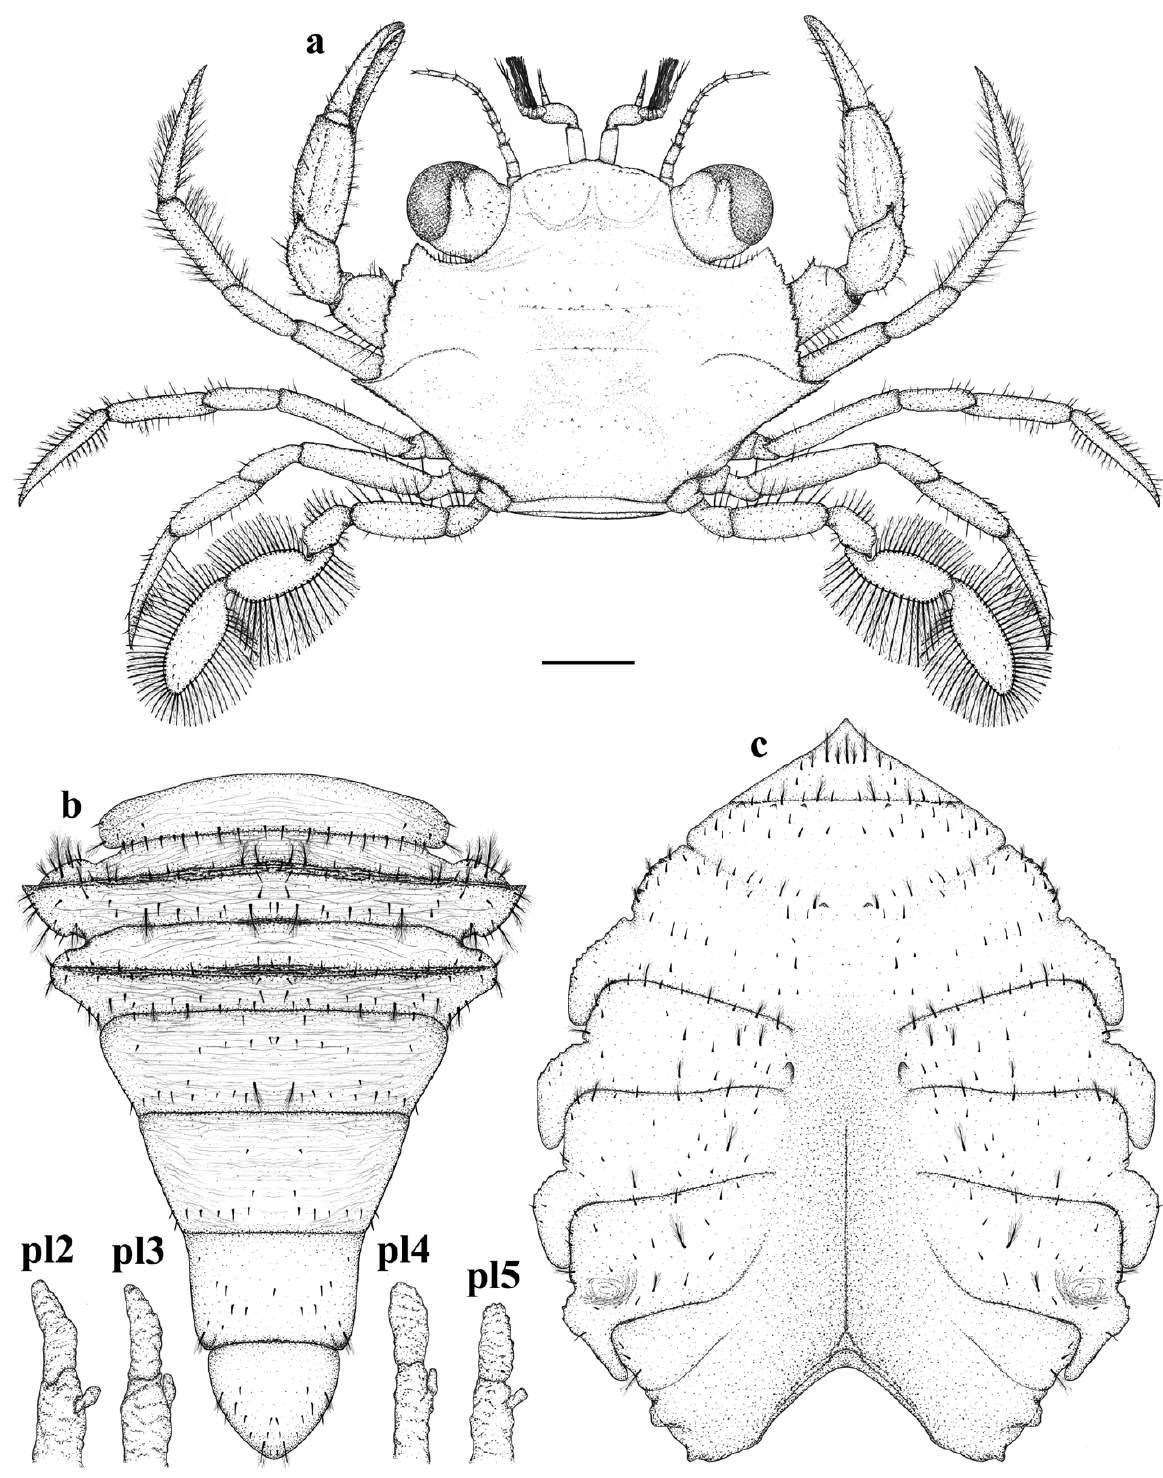
Figure 1 - Callinectes danae . 1 st undifferentiated stage: A , dorsal view; B , abdomen (dorsal view); C , sternum (ventral view); pl2-pl5 , rudimentary pleopods (from 2 nd to 5 th abdominal somites). Scale: A , 0.5mm; B , C and pl2-pl5,